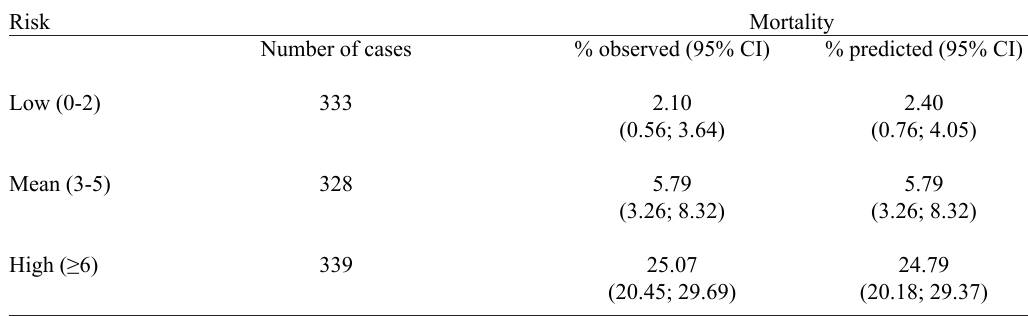
Table 2. EuroSCORE calibration - Analysis by risk